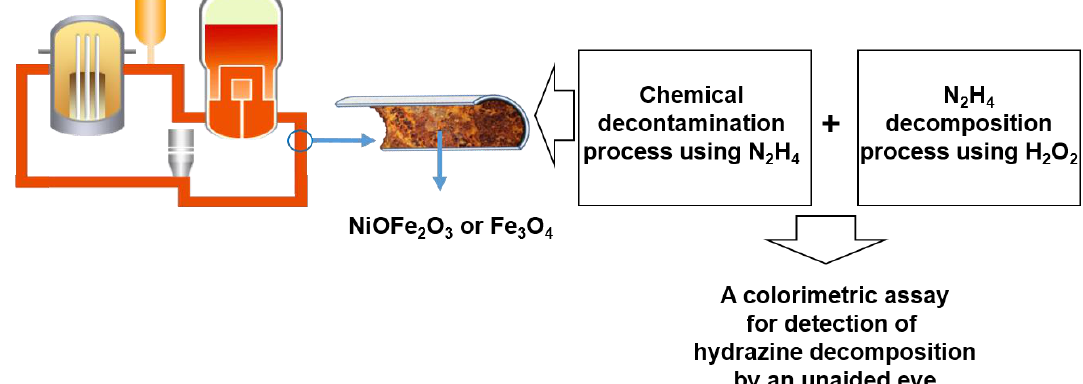
Figure 1. Schematic diagram of a colorimetric assay for detection of hydrazine decomposition of internal surfaces with an oxidation of vessels or pipelines in a nuclear power plant.